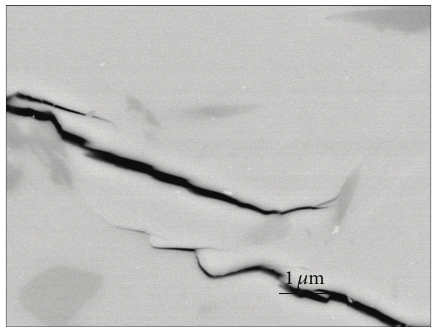
Figure 8: FESEM image of crack propagation paths in Cr-Ni-Al alloy phases.